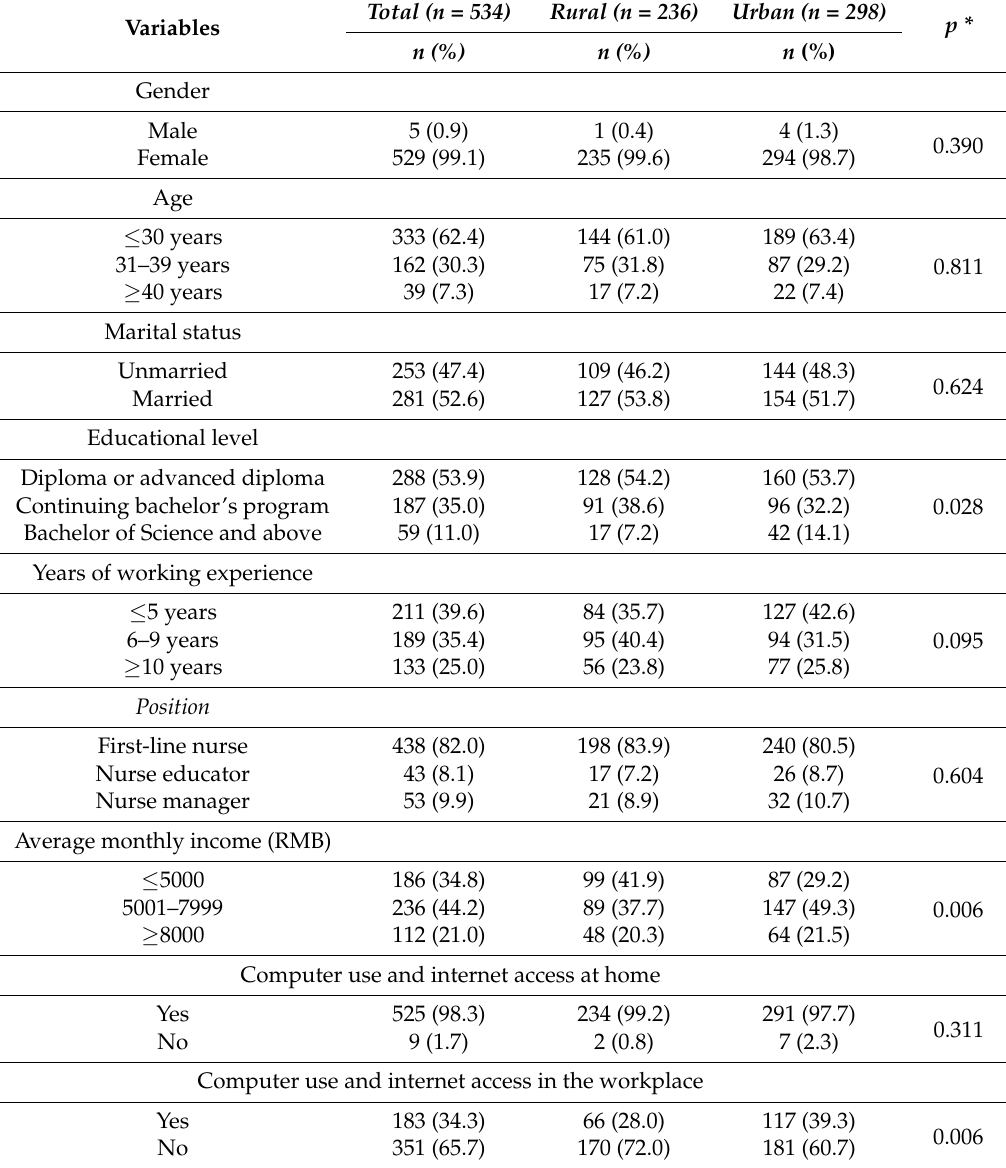
Table 1. Participants’ demographic and background